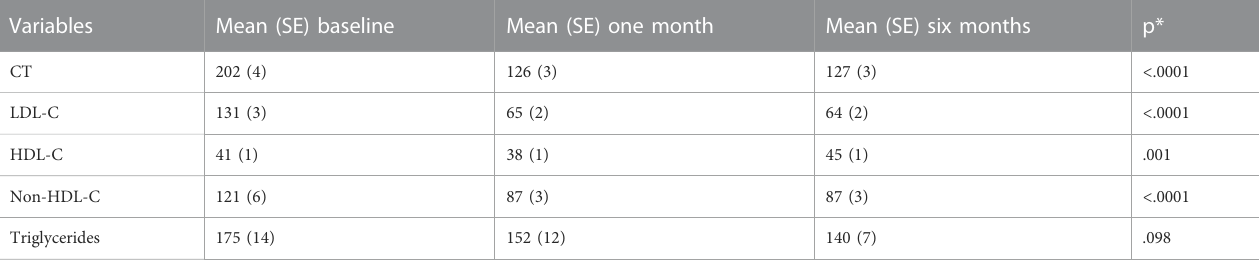
TABLE 2 Lipid pro fi le during the study.